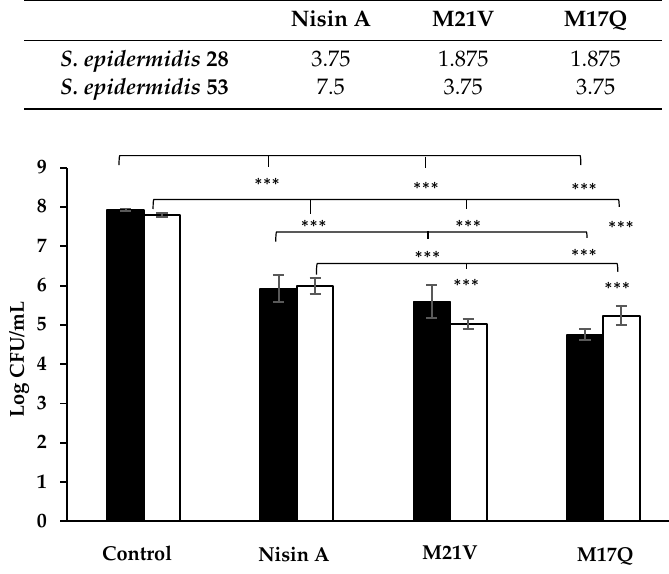
Figure 2. Images are representative of the average zones of clearing obtained when 30 µL of a 30 µM stock of each peptide was added to well in Tryptone soya agar. Plates were incubated at 37 °C overnight. Table 2. Minimum inhibitory concentration (MIC) values for wild type peptide nisin A and its derivatives M21V and M17Q against S. epidermidis . All values in the Table are µM. Nisin A Nisin